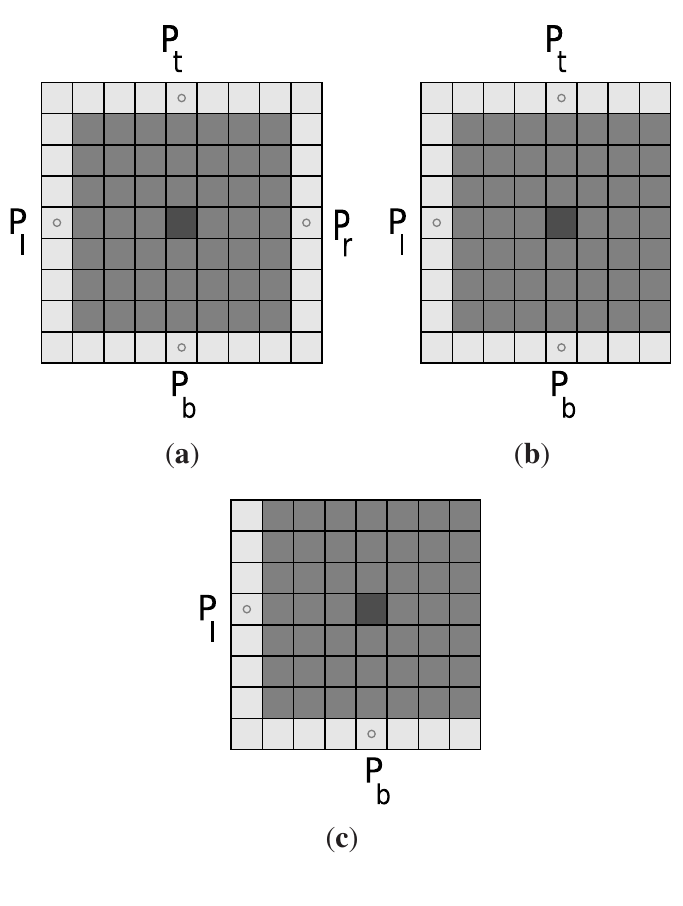
, P , P , P , P }, { P }, { P } or { P } t r l t l b b r